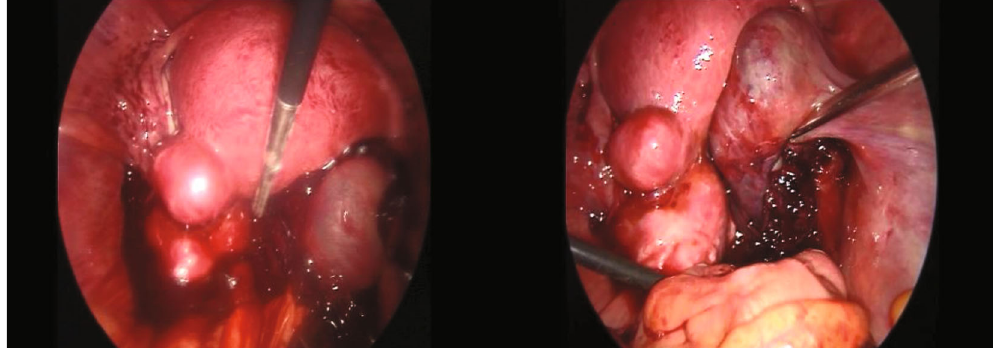
Figure 3: Hemoperitoneum. Ruptured ectopic pregnancy of the right fallopian tube.